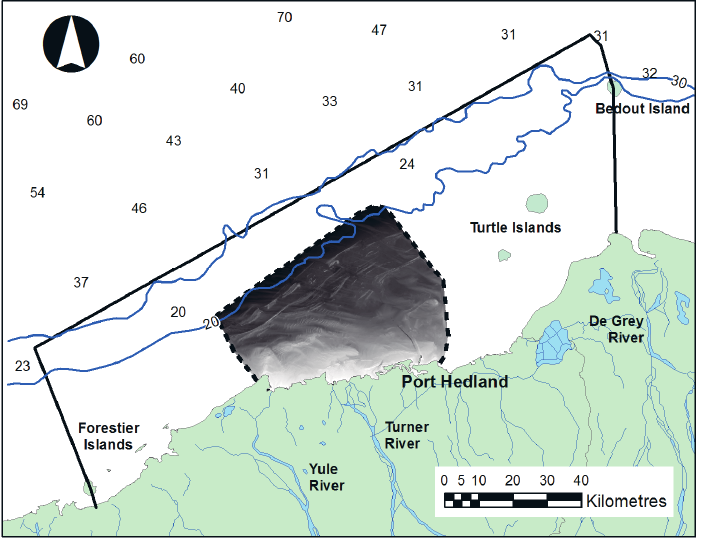
Figure 2. LiDAR region encapsulated the region shown as the dotted line representing the sea floor offshore of Port Hedland. The secondary outer black line represents the regional hydrodynamic model